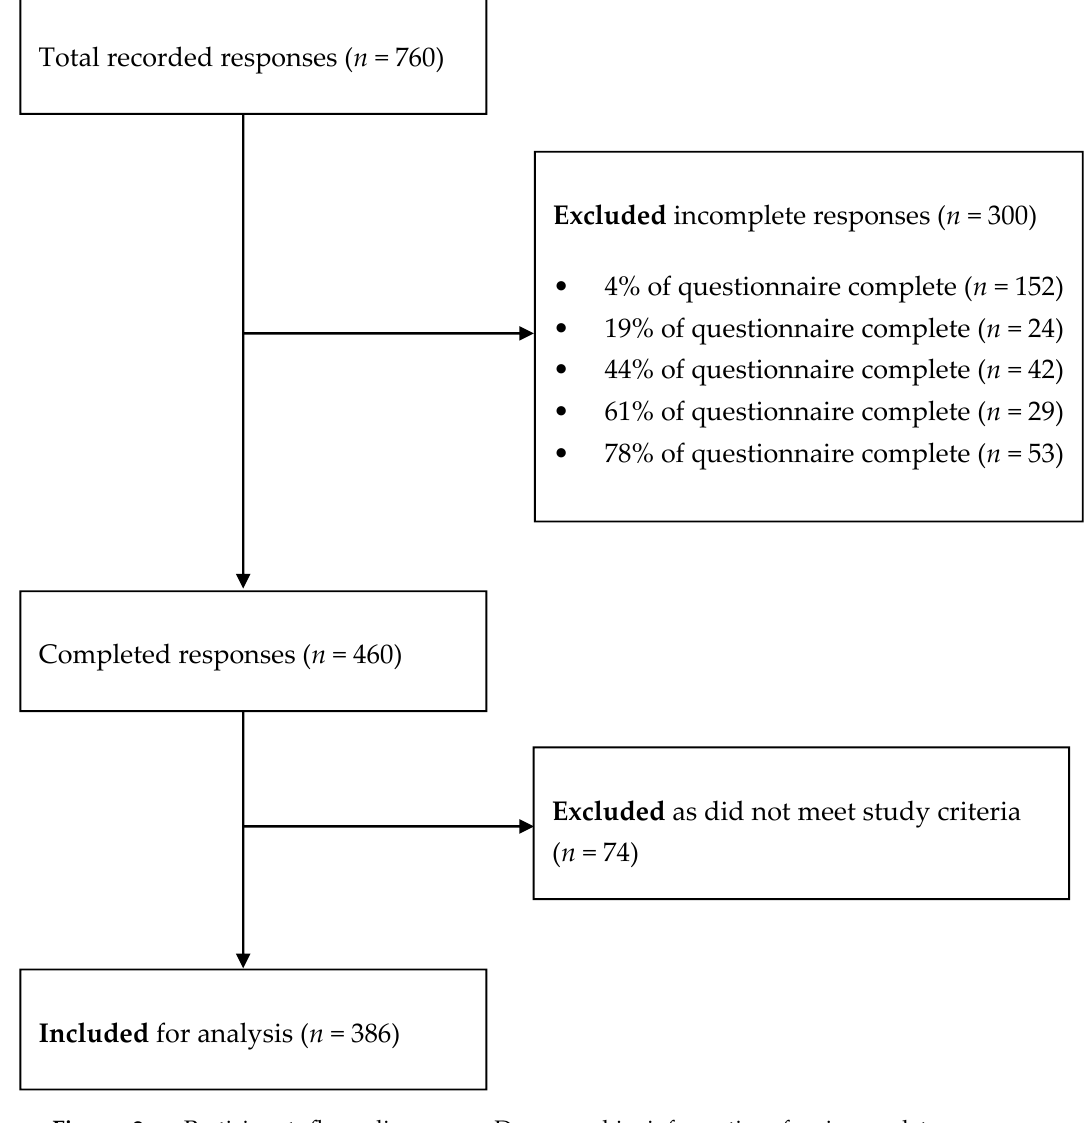
Figure 2. Participant flow diagram. Demographic information for incomplete responses was